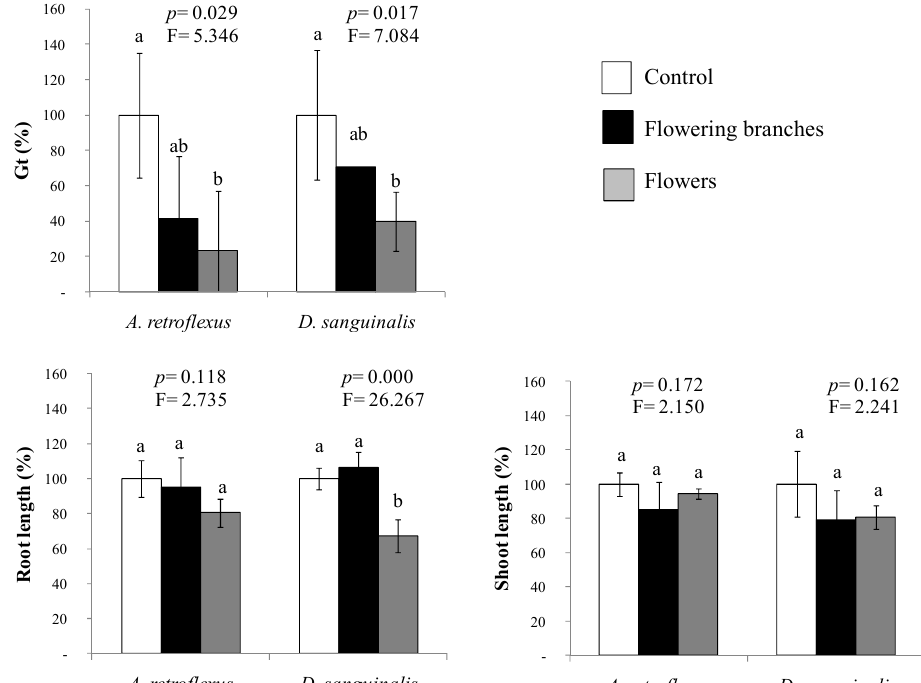
Figure 2. Effects of a mixture of phenolic compounds, prepared by mimicking the aqueous extract of Cytisus scoparius flowering foliage or only flowers, applied in Petri dishes on the total percentage of germinated seeds (Gt) and early growth of two agricultural weed species ( Amaranthus retroflexus and Digitaria sanguinalis ). Mean values of four replicates are represented in percentage relative to control. Error bars represent standard deviation (S.D.). For each target species, p - and F-values of the effects of treatments from one-way ANOVA or Kruskal-Wallis H tests are shown. Mean values labeled with distinct letters denote statistically significant differences among treatments (post hoc LSD or Tamhane’s T 2